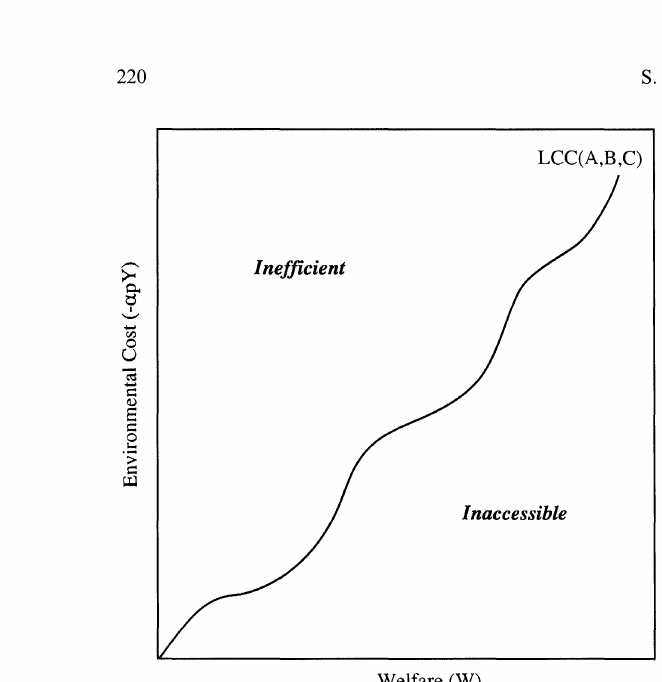
FIGURE The environmental cost of sustainable